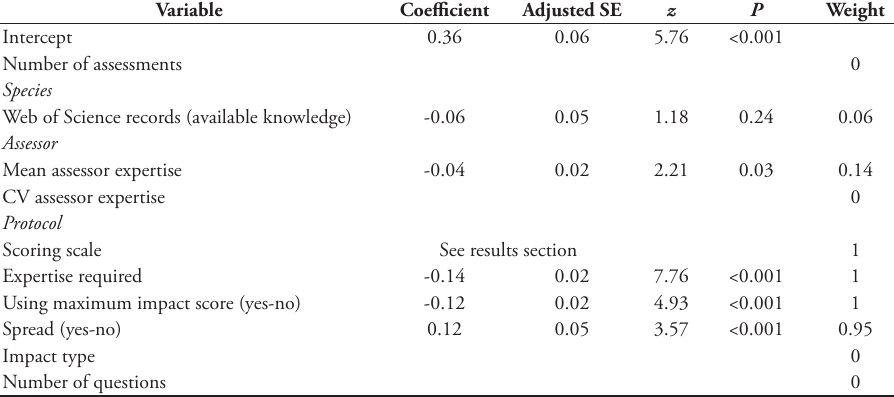
Table 2. Average coefficient and Akaike weights for each species, assessor and protocol variable within the best linear mixed models (AIC < 6) explaining the coefficient of variation of the scores of 57 non-native c species in 11 impact assessment protocols. Taxonomic groups and species identification were included as nested random effect. Predictors with weight closer to one have a higher relative importance to explain the response variable. Variables with weight equals zero were not included in the best subset of models to calculate average